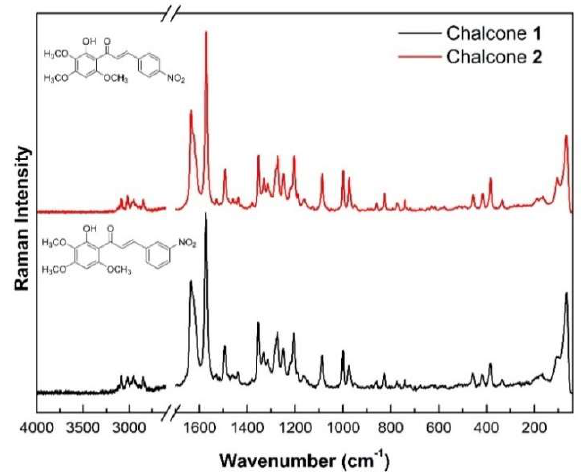
Figure 6. Experimental FT-Raman spectra of chalcones 1 and 2. Appl. Sci. 2020 , 10 , x